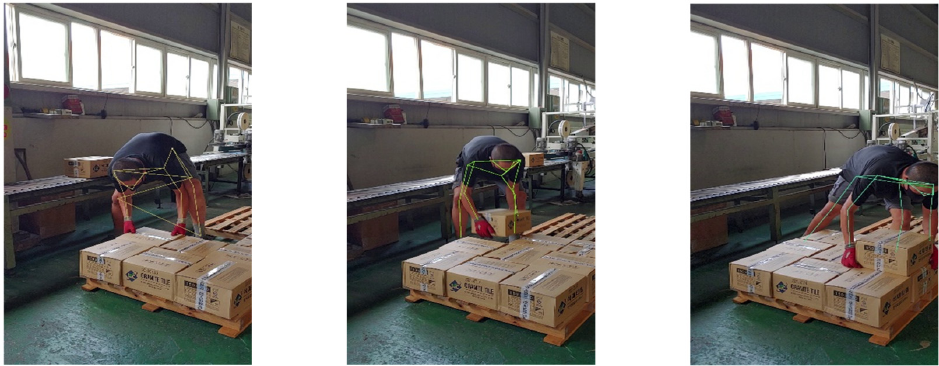
Figure 5. Occluded image data with low reliability. Table 1. Example of OWAS score chart for input images.